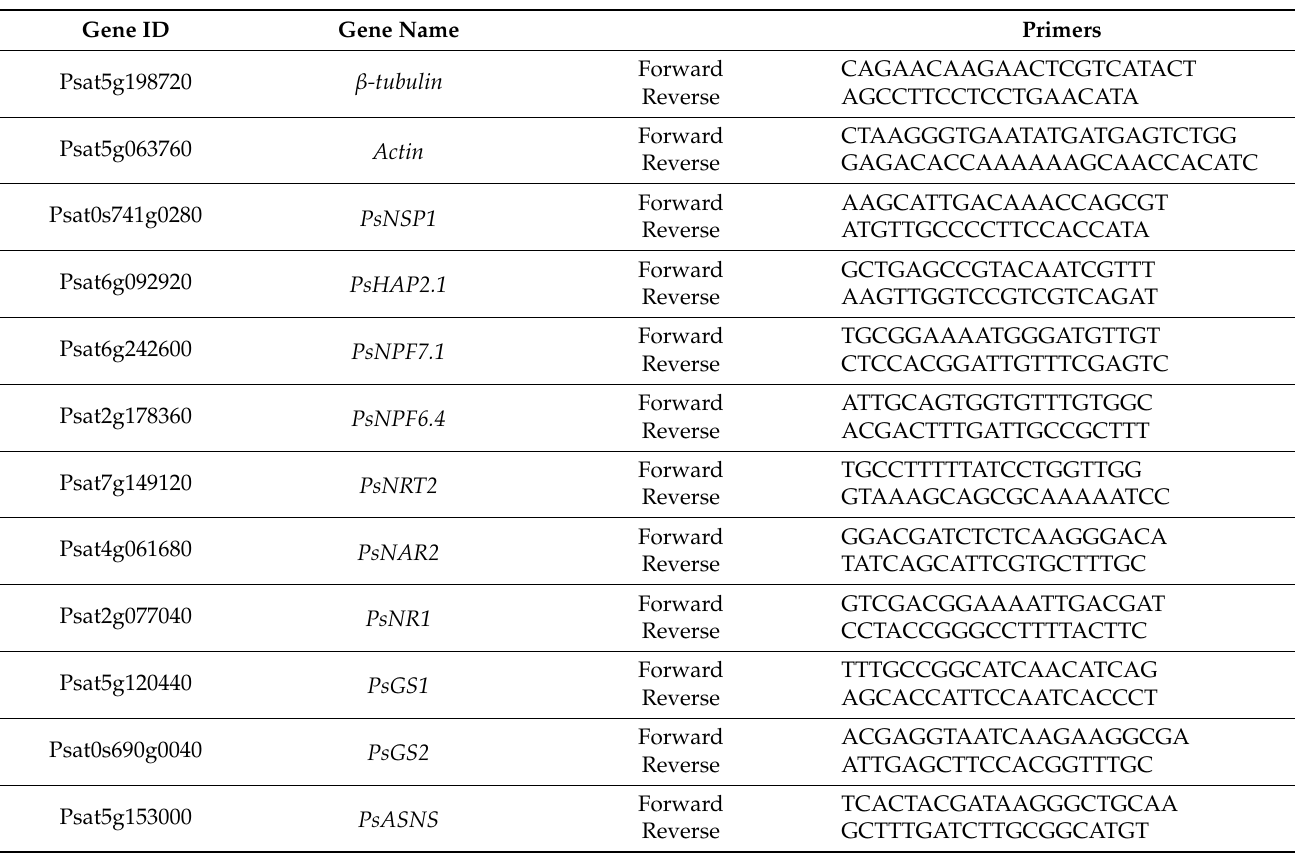
Table 2. List of primer sequences used for PCR